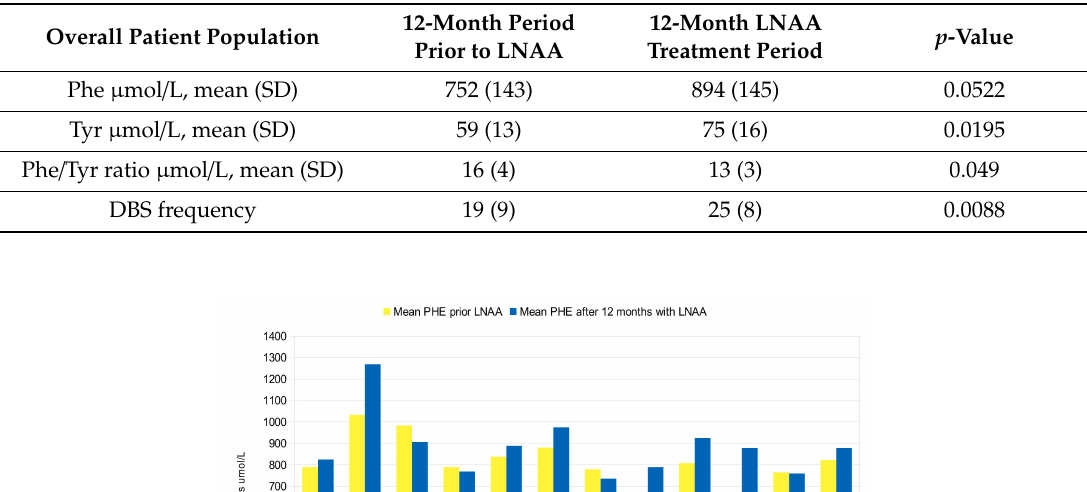
Table 5. Phe, Tyr, Phe / Tyr ratio, and DBS frequency over the 12-month period prior to the introduction of LNAA and over the 12-month LNAA treatment period for the overall patient population.